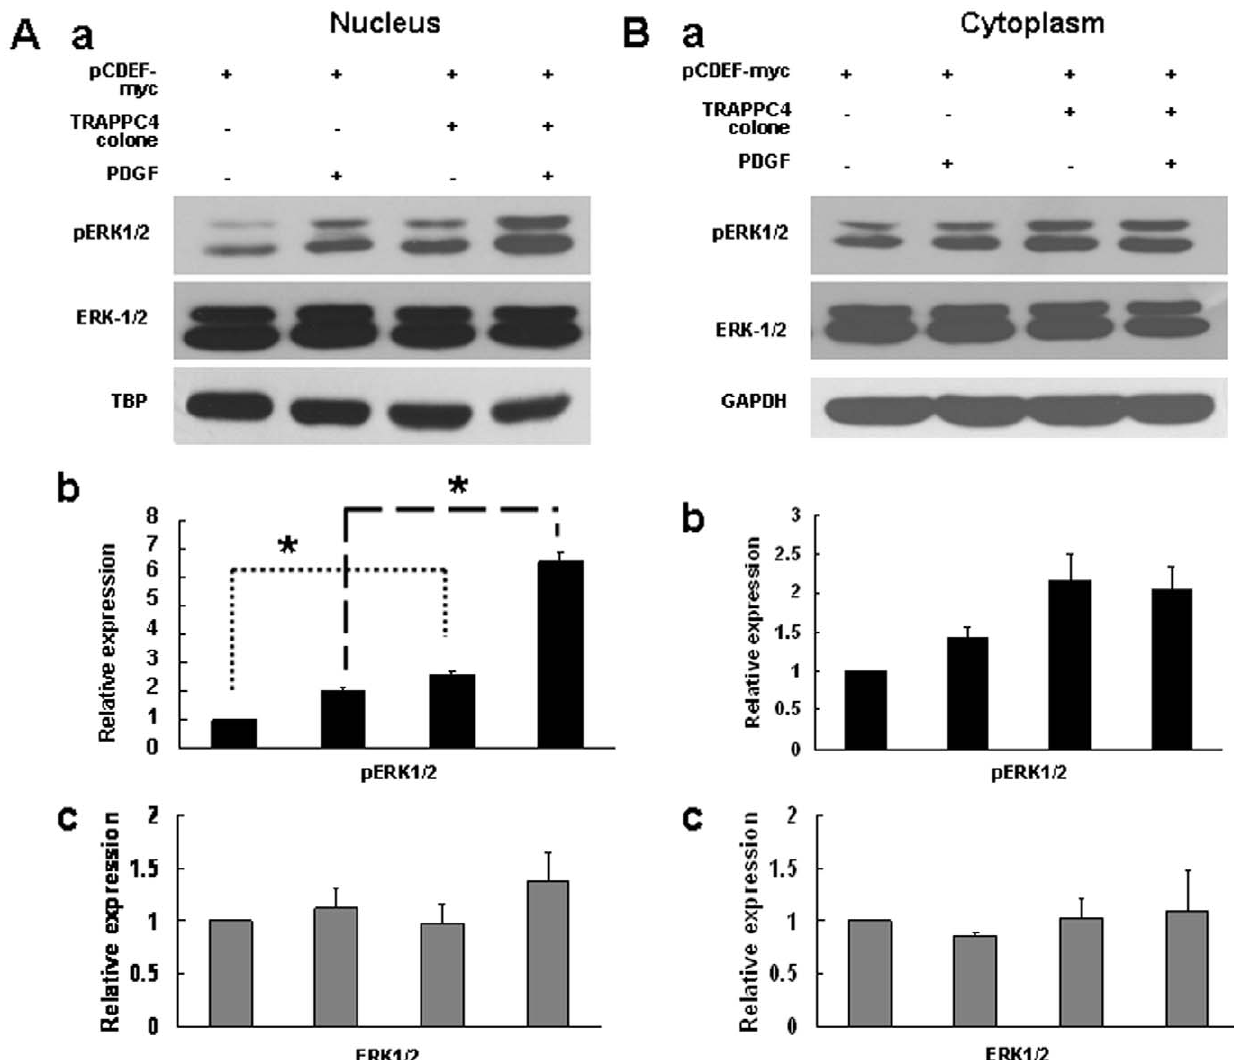
Figure 4. Overexpression of TRAPPC4 increased actived ERK1/2 level in nucleus on SW1116 cell line. SW1116 cells were transfected with pCDEF-myc-TRAPPC4 vector to overexpress TRAPPC4 protein or with pCDEF-myc vector as control; Also cells were treated with PDGF to activate ERK-MAPK pathway, or with its solvent (PBS + 0.1% BSA) as control. Nuclear (A) and cytoplasm (B) extracts were prepared as described in experimental procedures, and equal amounts of protein were analyzed by Western blot analysis using antibodies against phospho-ERK1/2 (pERK1/2), or ERK1/2, or TRAPPC4. The density of the Western blot bands were normalized to the amount of TBP for nuclear protein or GAPDH protein for cytoplasma protein. The data shown are representative of three replicate experiments. *, p ,